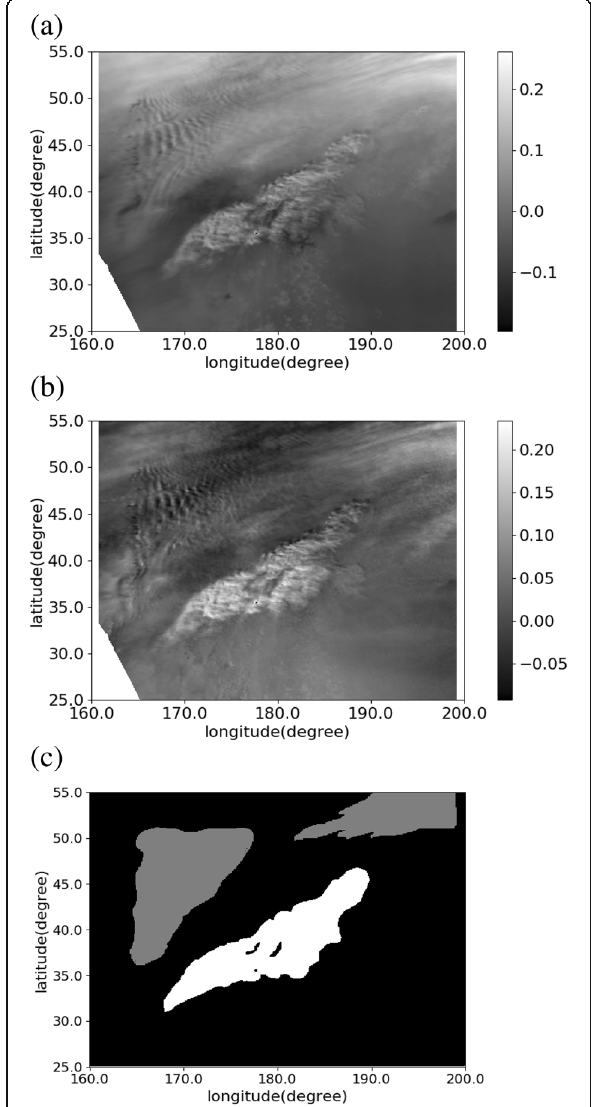
Fig. 1 Examples of images and ground truth of dust and cloud distributions used in this study. a An example of a pre-processed image in the red band. The albedo patterns on the surface and topography (e.g., craters) are recognized visually in the bottom of the image although they are weaker than the dust storm seen in the center of the image. b The subtracted image produced from a . c The ground truth of the distributions of dust storms and clouds seen in a and b . We prepare the ground truth subjectively based on the red and blue band